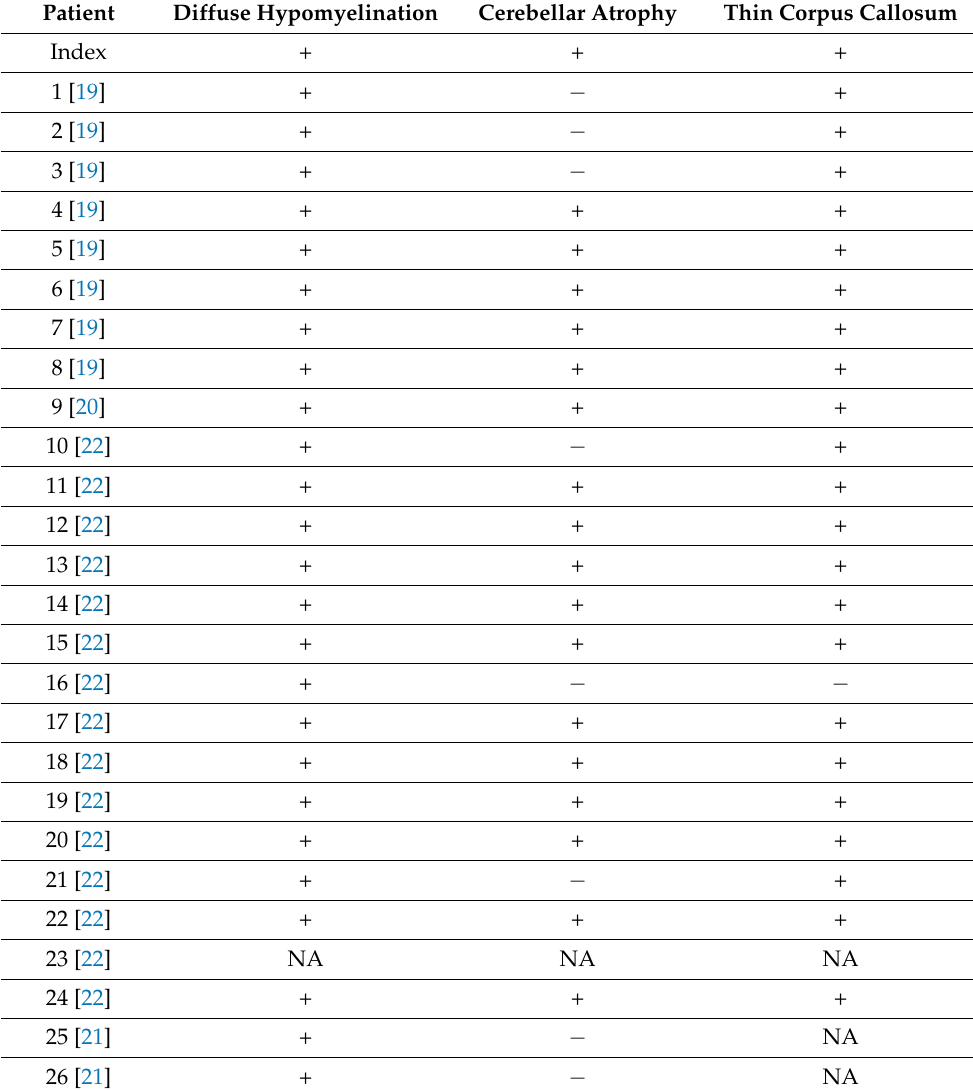
Table 3. Main MRI characteristics of our patient and reported patients with POLR1C